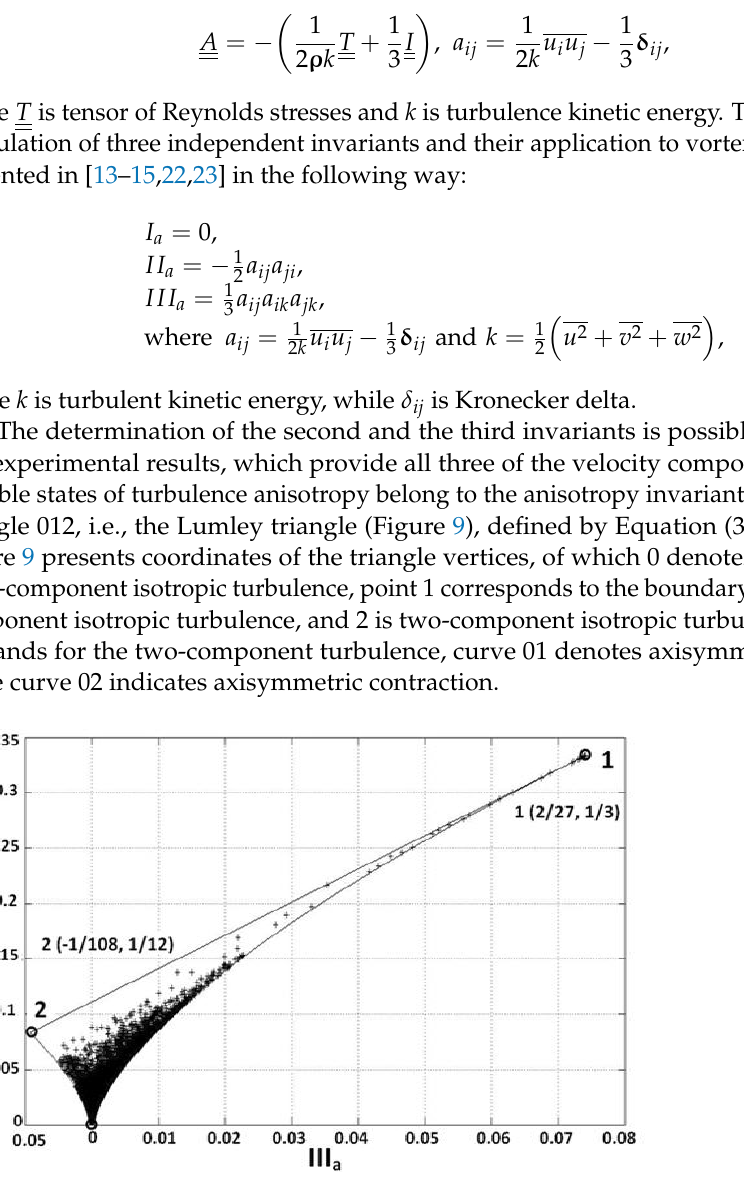
Figure 9. Anisotropy invariant map (Lumley triangle) for experimentally obtained results [14]. A set of values ( III a , - II a ) for 11,210 points, obtained by 2771 image pairs in the time period of approximately 1.4 s, is presented in the Lumley triangle (Figure 9). It is obvious that all the values belong to the domain of the invariant map. The invariant map in Figure 9 includes various physically possible turbulence states in the measuring cross-section. The coordinates of the measurement point closest to the coordinate system origin ( x0y )